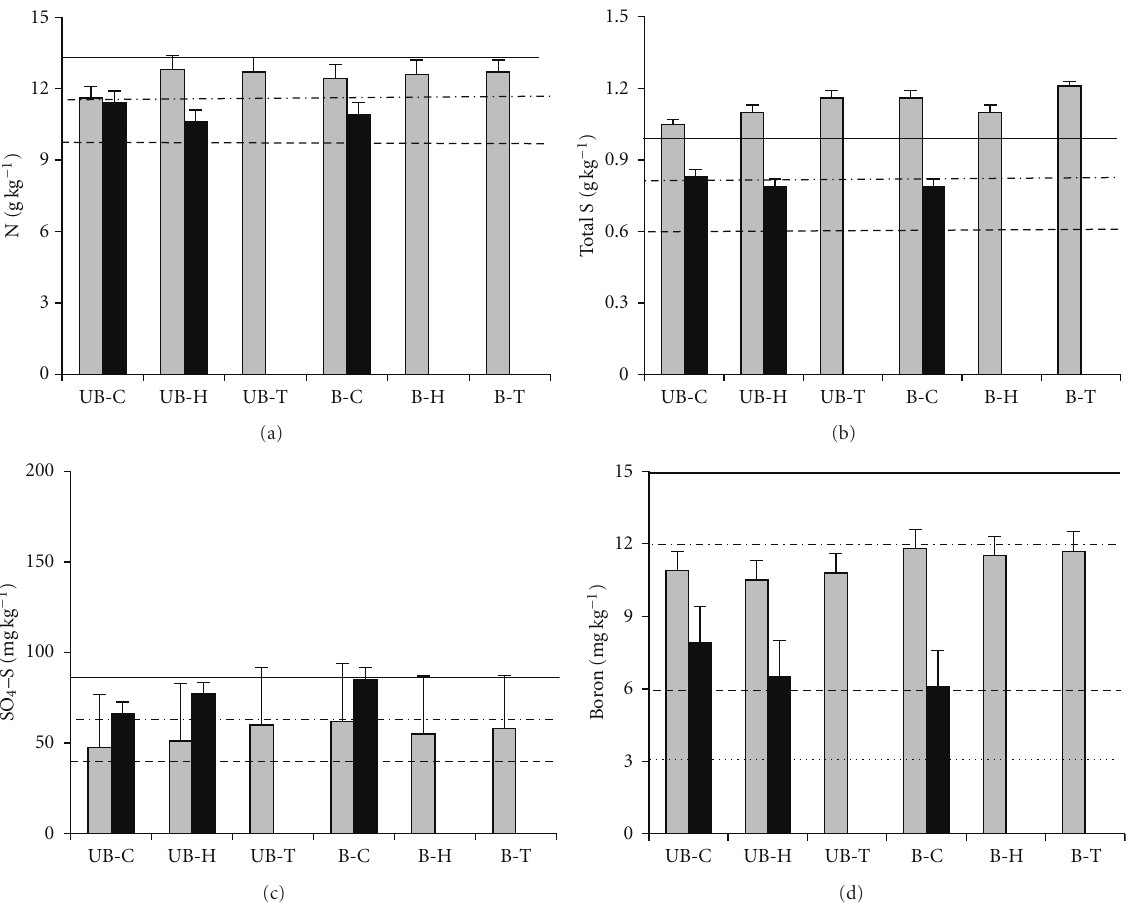
Figure 2: Mean foliar concentrations of (a) total N (gkg − 1 ), (b) total S (gkg − 1 ), (c) SO 4 -S (mgkg − 1 ), and (d) B (mgkg − 1 ) in years 10 (gray bars) and 20 (black bars). Error bars are one standard error. Refer to Table 3 for Bonferroni mean separation. For N, S, and SO 4 -S, concentrations are adequate above the solid line, slightly to moderately deficient between the solid and dashed-dotted lines, moderately to severely deficient between the dashed-dotted and dashed lines, and severely deficient below the dashed lines. For boron, concentrations are adequate above the solid line, likely not deficient between the solid and dashed-dotted line, possibly deficient between the dashed-dotted and dashed lines, probably deficient between the dashed and dotted lines, and severely deficient below the dotted line (based on Brockley [27]). Refer to Table 1 footnotes for treatment